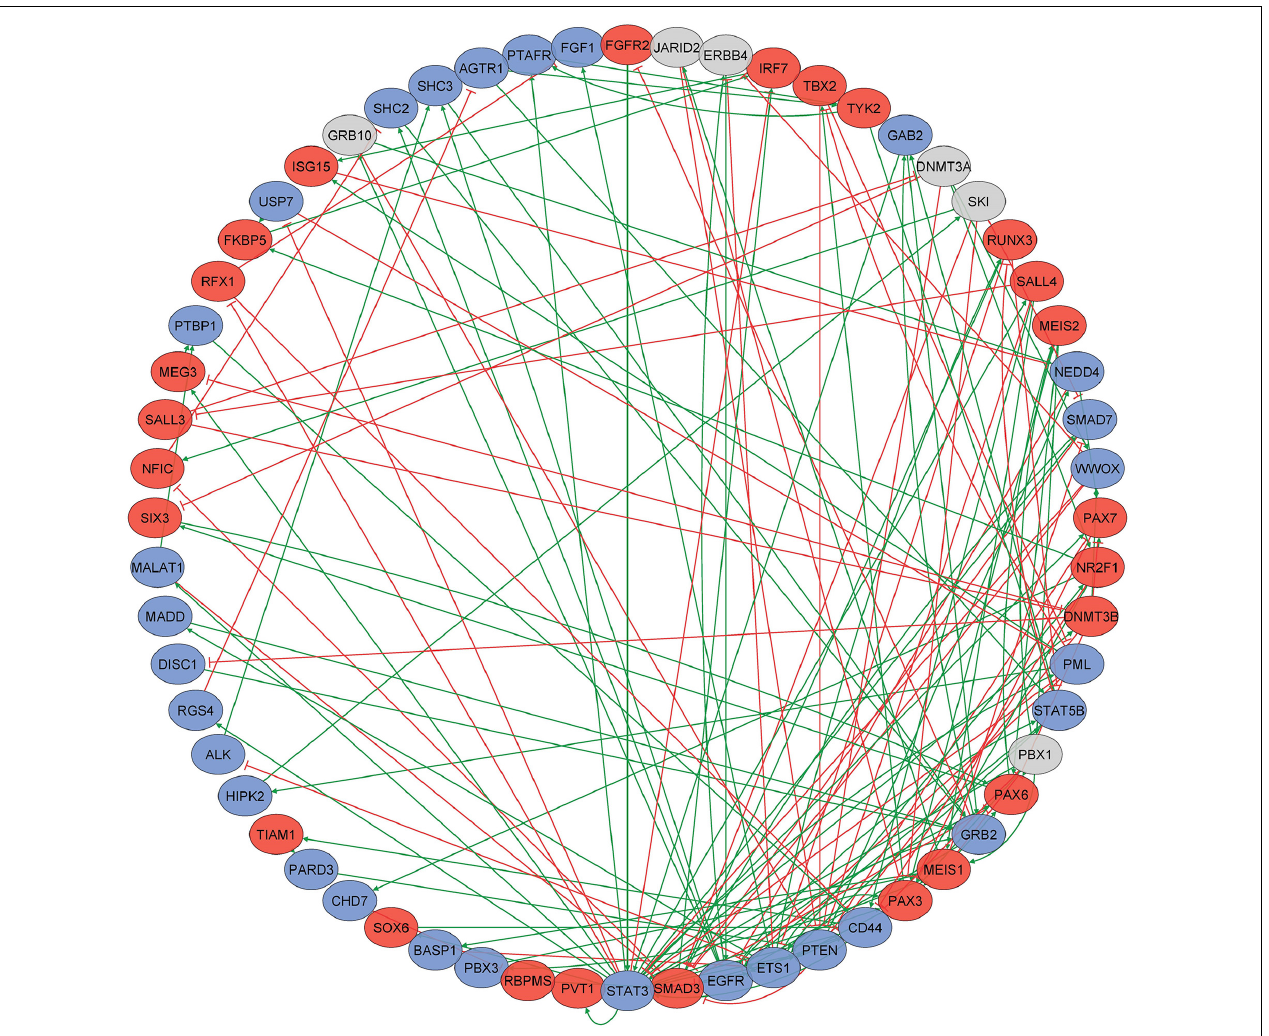
FIGURE 3 | A subnetwork of 60 genes constituting the strongly connected component (SCC) in the gene–gene interaction network. Directed gene–gene interaction network was constructed for 2,659 unique genes that were annotated to the 6,843 loci comprising the epigenetic trajectory signature. The prior knowledge network (PKN) obtained from Metacore contained 398 genes and 622 interactions. Only one strongly connected component (SCC) in this network, comprised of 60 genes and 158 interactions between them, was identified; blue nodes indicate genes becoming progressively hypomethylated, red nodes indicate genes becoming progressively hypermethylated, and gray ovals indicate genes that have more than one probe annotated to them that have different patterns of methylation